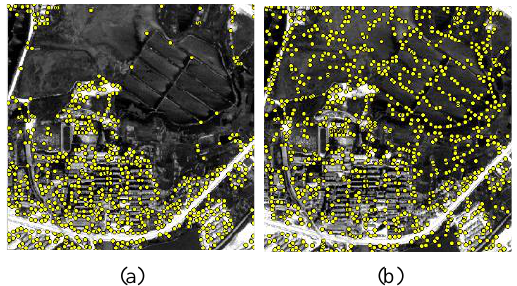
Figure 2. The Harris feature points extraction results by (a) fixed threshold on image and (b) non-overlap block- based scheme